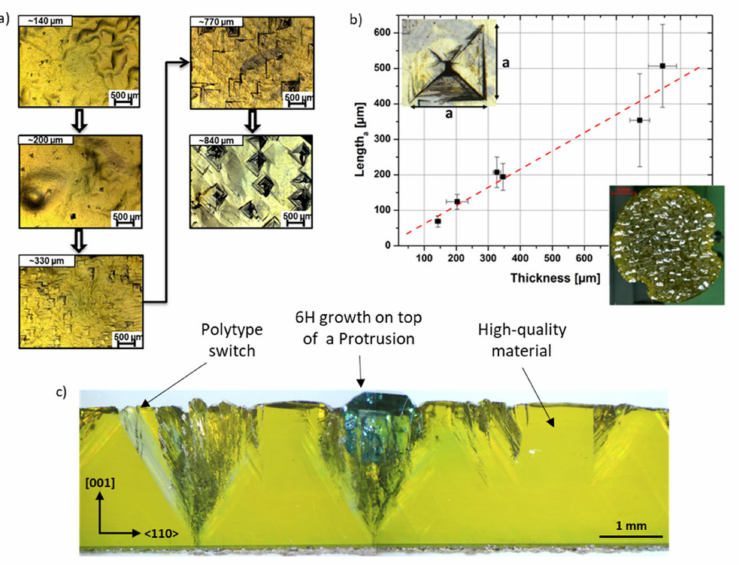
Figure 22. ( a ) Size of protrusion defects for bulk 3C-SiC layers with different 3C-SiC thickness. ( b ) Edge length of protrusions plotted versus 3C-SiC thickness. Additionally, the surface of an approximately 2.7 mm-thick grown crystal with a diameter of 25 mm is visible. The crystal is completely dominated with protrusion defects, leading to a ragged surface. ( c ) Cross-cut of a 3.4 mm-thick crystal revealing polytype switches as well as the inner parts of the protrusion defect. Areas between and underneath the protrusions show high quality material grown by